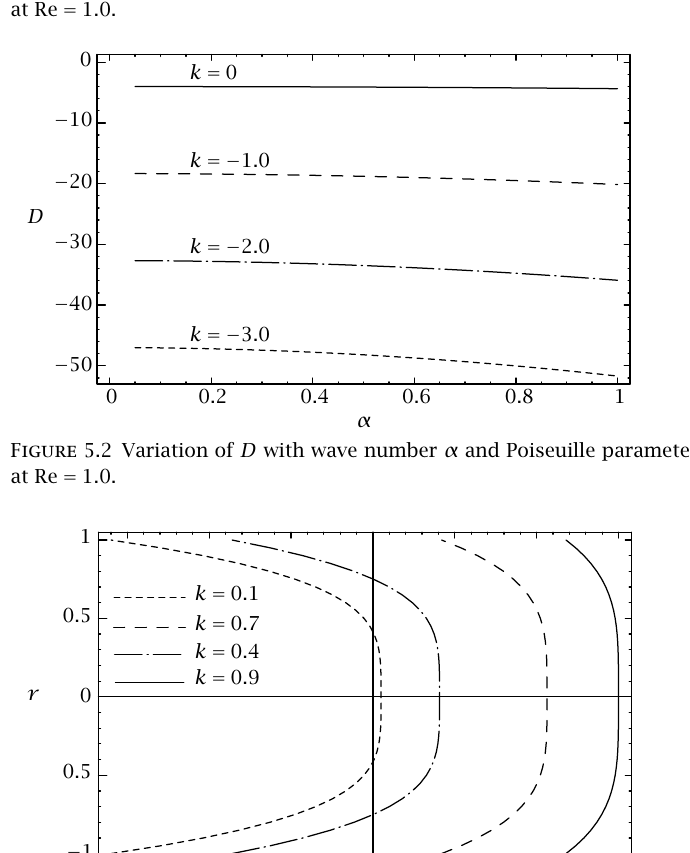
Figure 5.1 Variation of D with wave number α and Poiseuille parameter k at Re = 1 . 0.